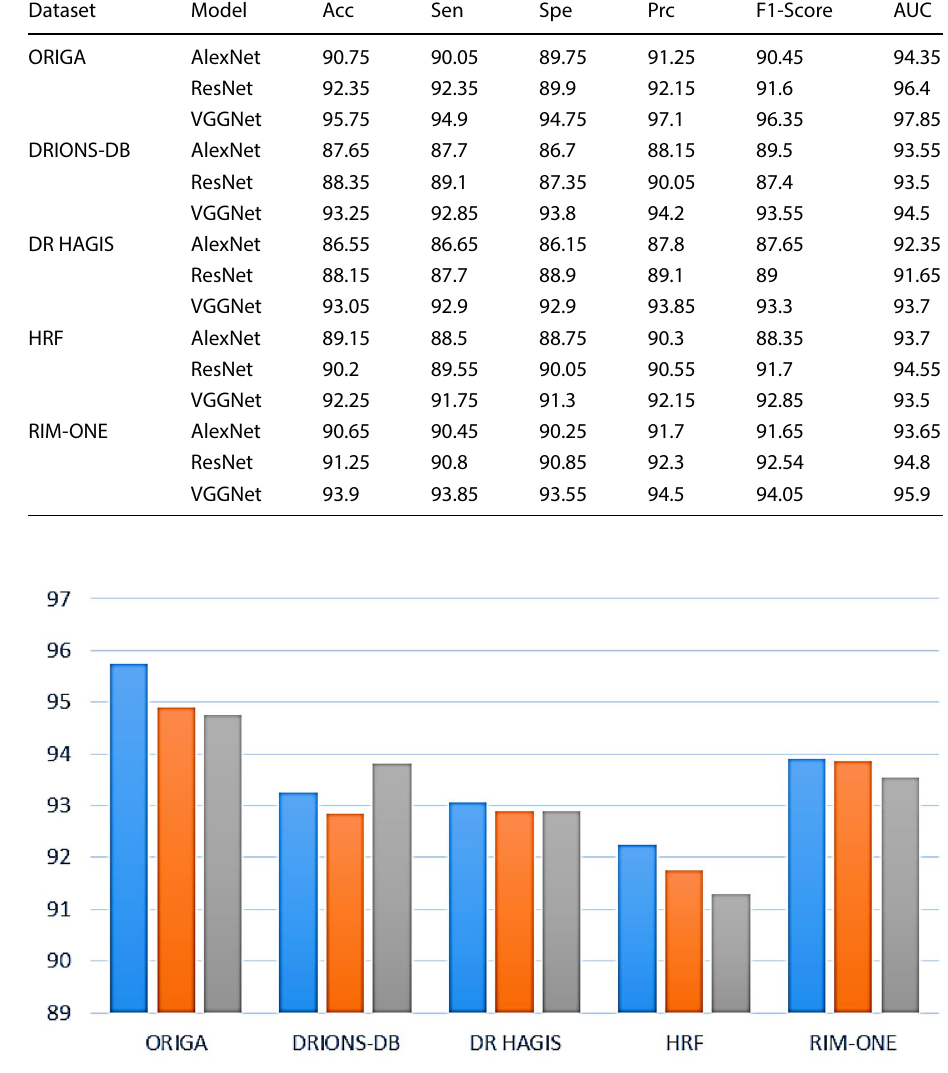
Table 5 Performance Evaluation of Transfer Learning Methods on Extracted ROI